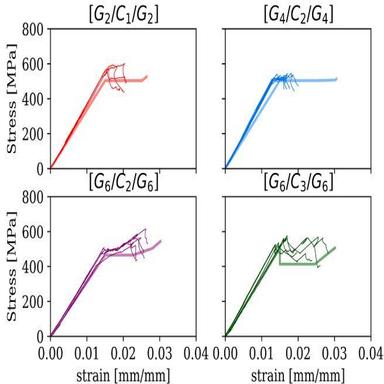
Effect of thickness of the low strain layer on the stress-strain response of hybrid 3D printed composite laminates. The bold lines represent the analytical predictions. (For interpretation of the references to colour in this figure legend, the reader is referred to the web version of this article.)